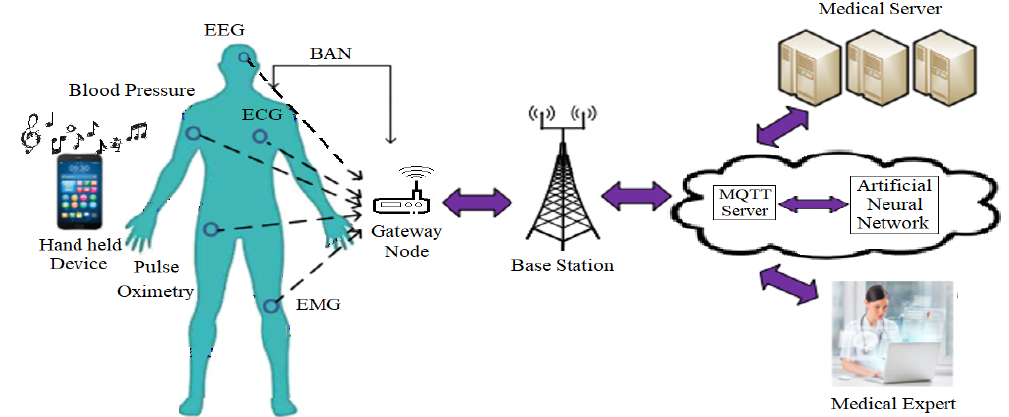
Figure 1. System level illustration and relevant components for integrating and ANN, BAN and music therapy.